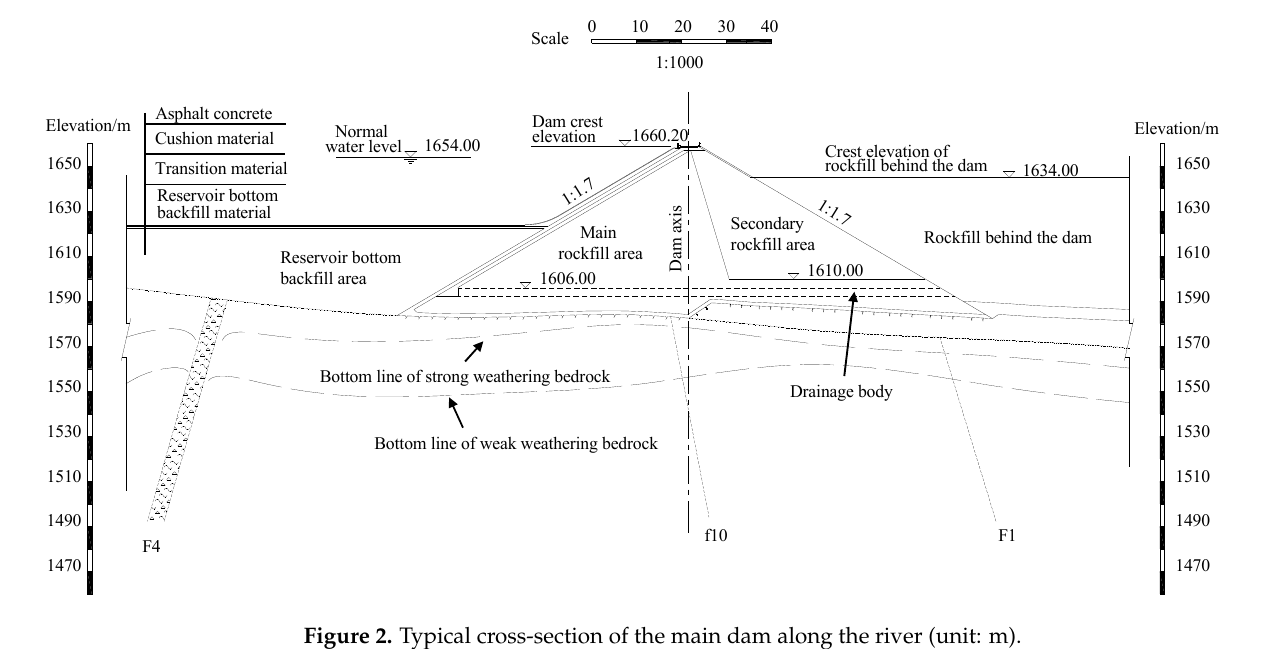
Figure 2. Typical cross-section of the main dam along the river (unit: m).